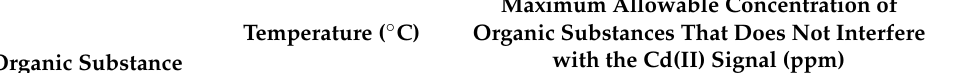
Table 3. Influence of CTAB, HA, and FA on the Cd(II) voltammetric signal at different temperatures. Concentration of Cd(II) 5 × 10 − 8